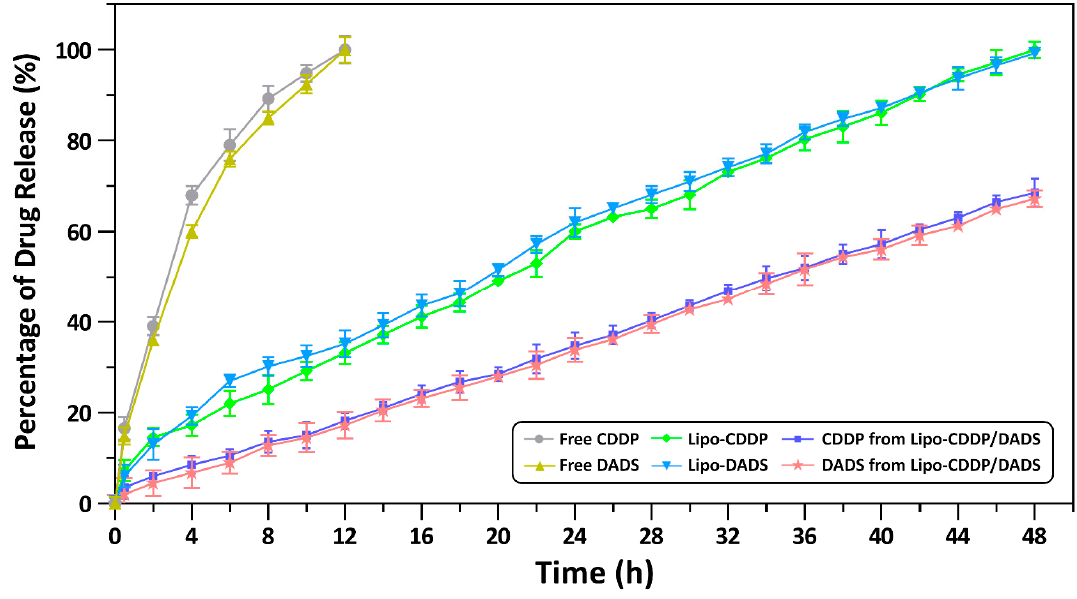
Figure 3. The drug release pro fi le of free drugs and drug(s)-loaded nanoliposomes.